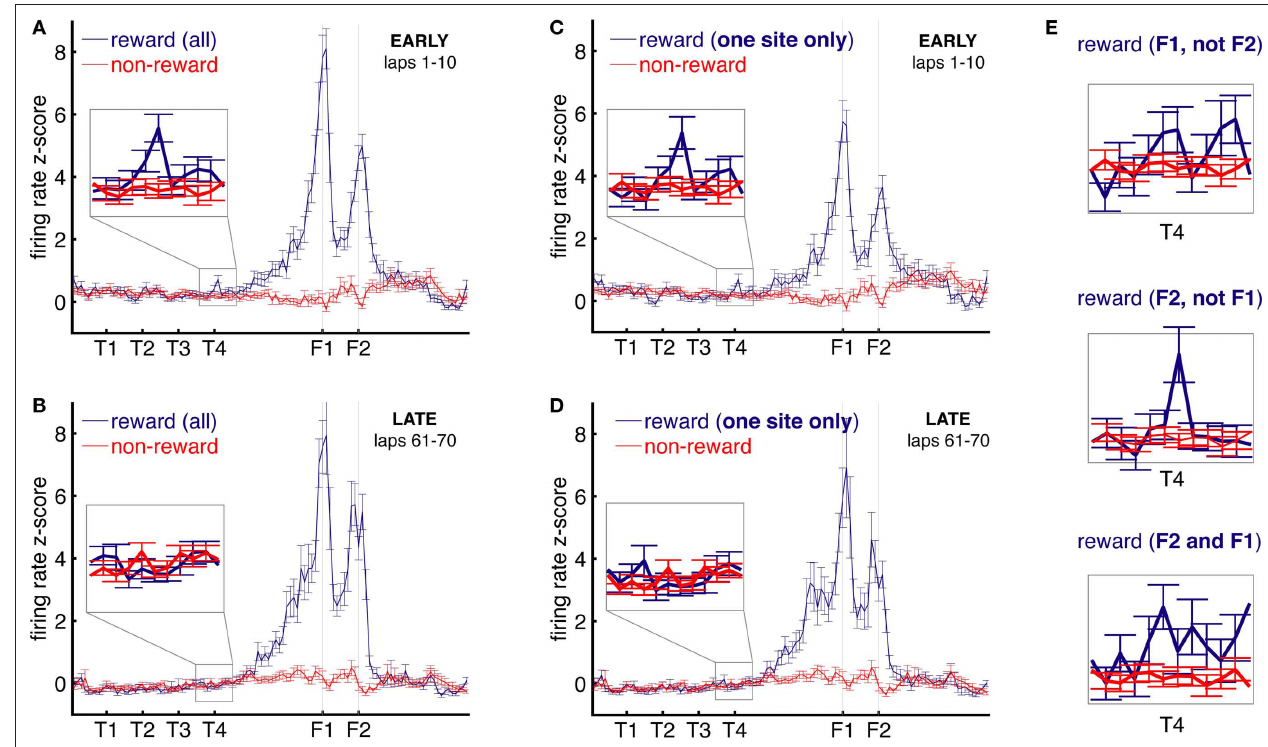
FIGURE 5 | Reward-responsive cells, but not non-reward cells, show increased fi ring at the fi nal choice point (T4) during early laps. (A) Averaged over all cells, average z -scored fi ring rate is increased at the fi nal choice point (T4) during early laps (1–10) for reward-related (blue), but not non-reward-related cells (red). During late laps (61–70), there was no such difference (B) . Note how during late laps, while there is no increase in reward cell fi ring at T4, the response